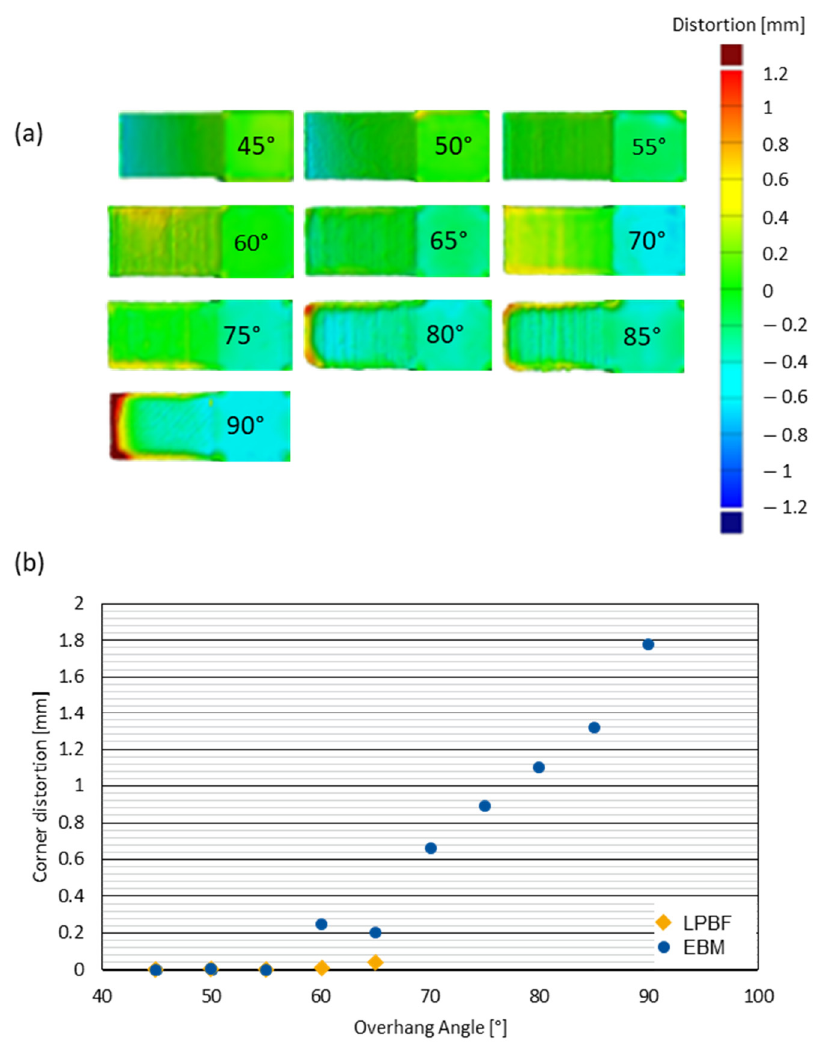
Figure 7. Distortion in overhangs depending on the overhang angle. ( a ) Visual representation of EBM overhang distortion. ( b ) EBM and LPBF distortion plotted against overhang angle.